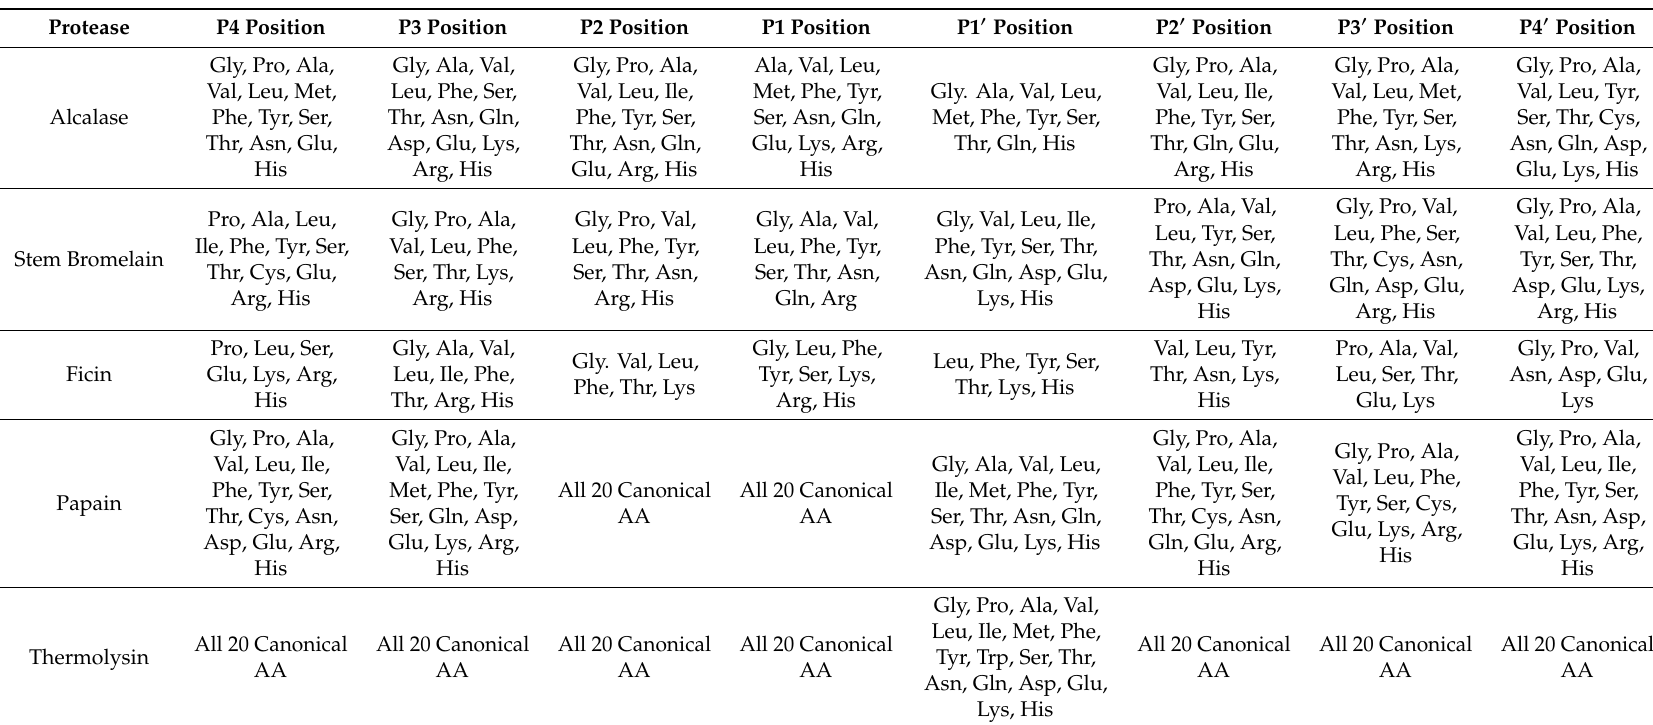
Table 1. Possible Amino Acids at Positions in or Around Cleavage Site for Specific